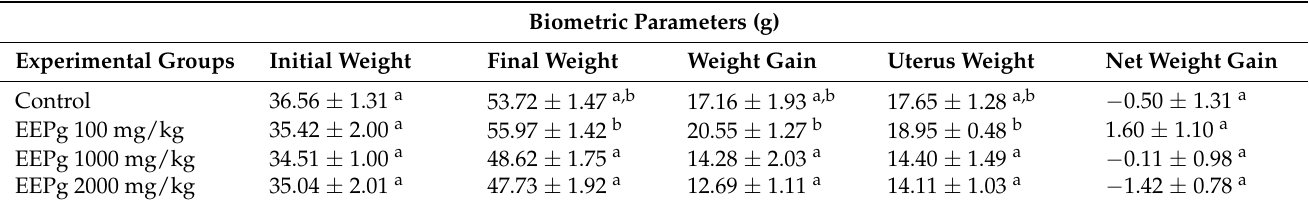
Table 1. Mean values ± standard error of the mean of the biometric parameters of females treated with the ethanolic extract of P. glabratum (EEPg).